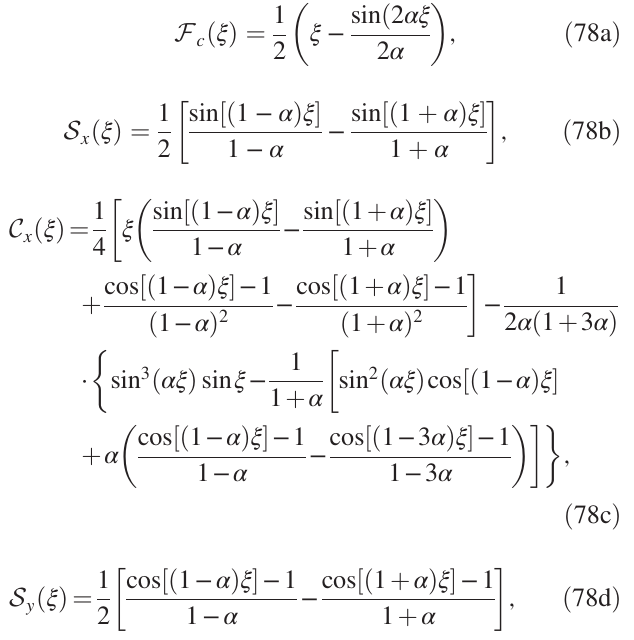
The integral for time in Eq. (74) can be evaluated in closed form (not given here) or by computing the simple summa- tion approximating the integral.